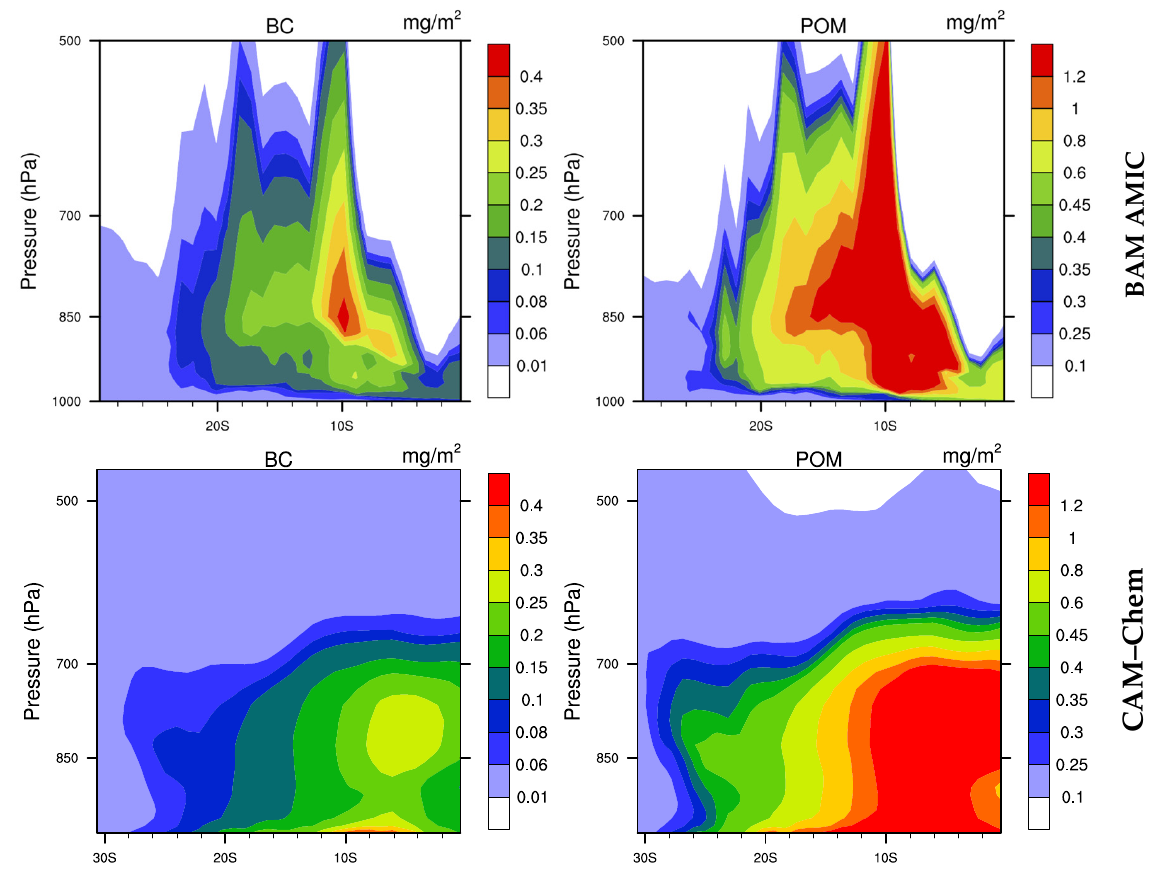
Figure 8. Vertical distribution of the mass concentrations (in mg/m 2 ) of BC and POM during the intense biomass burning event of 15–22 August 2019 over Amazon simulated by BAM AMIC (top) and CAM–Chem.